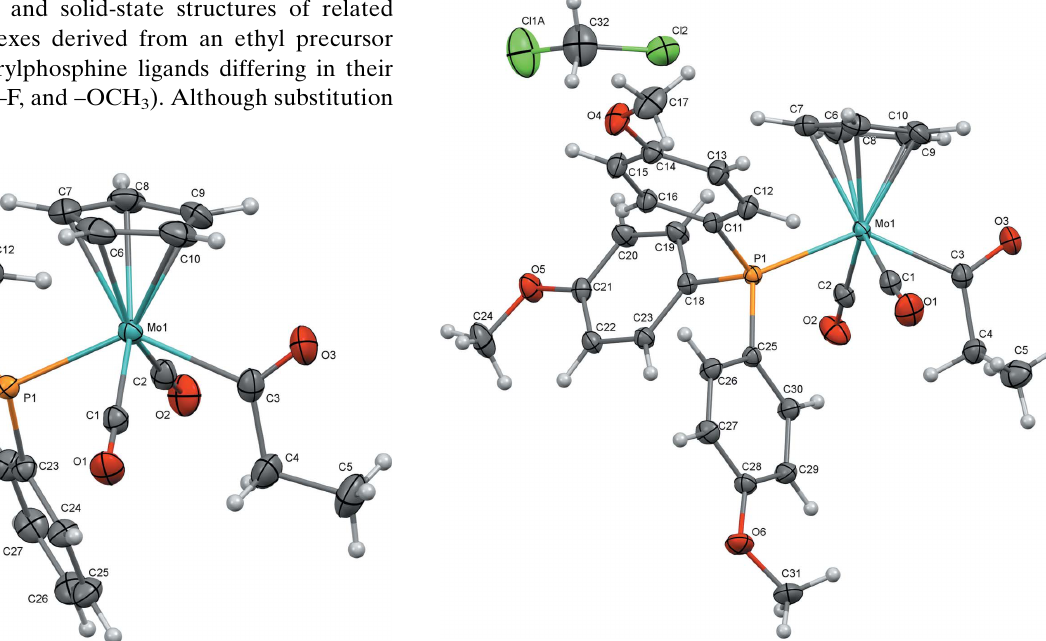
Figure 3 Molecular structure of ( 3 ) with ellipsoids at 50% probability.